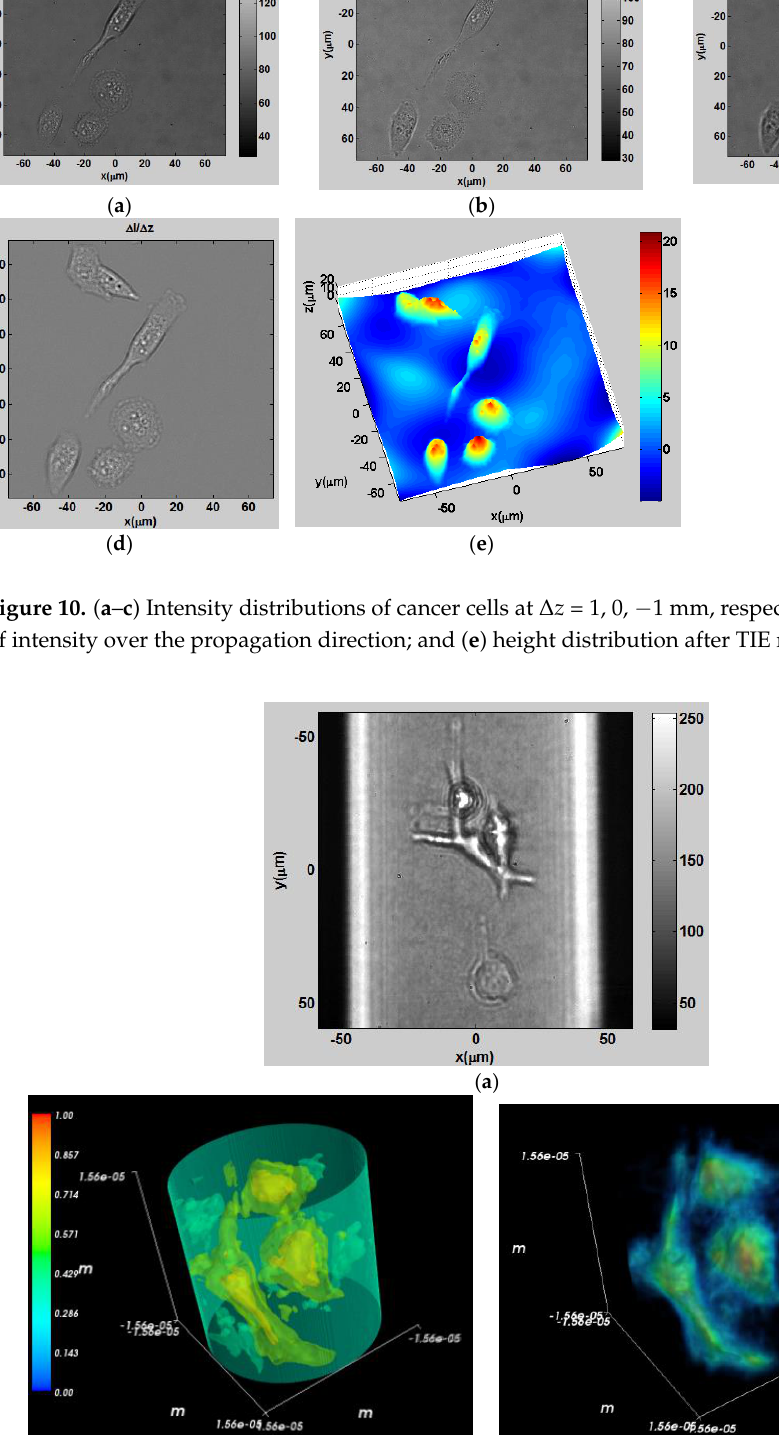
( b ) Figure 12. ( a ) Laboratory optical setup of the SLM based TIE system and ( b ) Arduino-controlled rotating stage assembly.